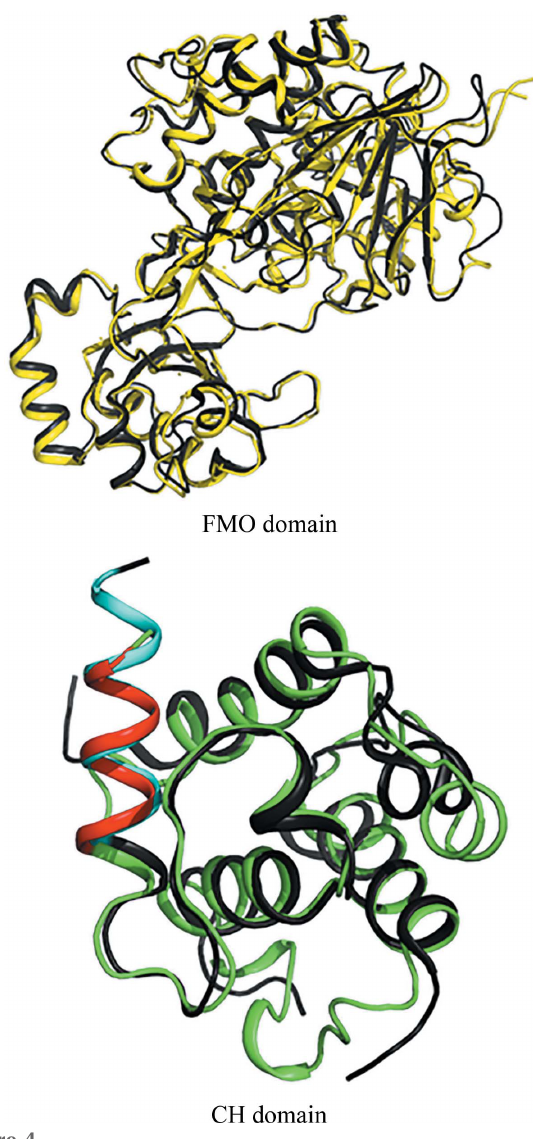
Figure 4 Superimposition of the FMO and CH domains of human MICAL3 and mouse MICAL1. In the upper panel, the FMO domain of human MICAL3 is shown in yellow and the FMO domain of mouse MICAL1 is shown in black. In the lower panel, the CH domain of human MICAL3 is shown in green and the CH domain of mouse MICAL1 is shown in black. The red helix is the actin-binding helix of human MICAL3 and the cyan helix is the actin-binding helix of mouse